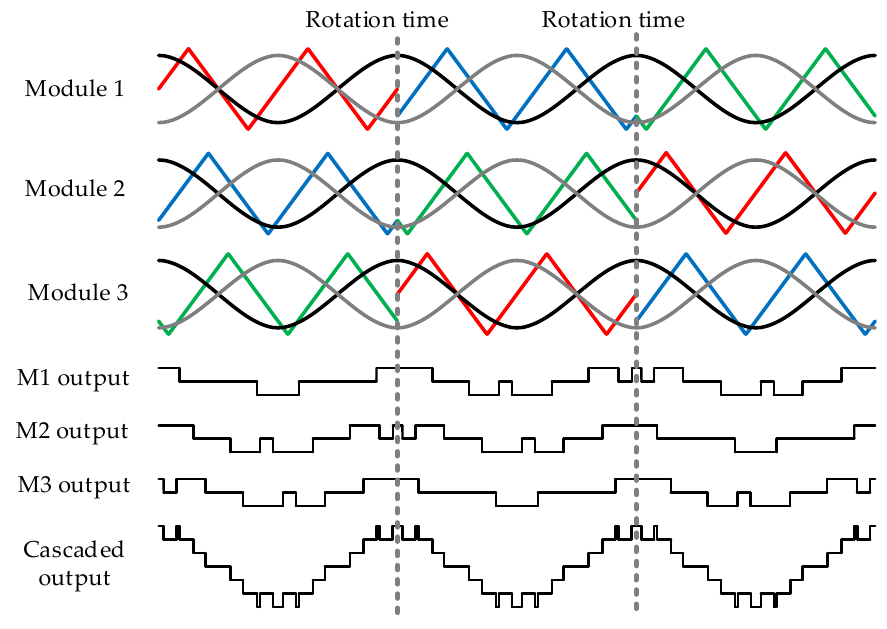
Figure 9. CPRS ‐ PWM scheme with the rotation time at the reference maximum point. Figure 9. CPRS-PWM scheme with the rotation time at the reference maximum